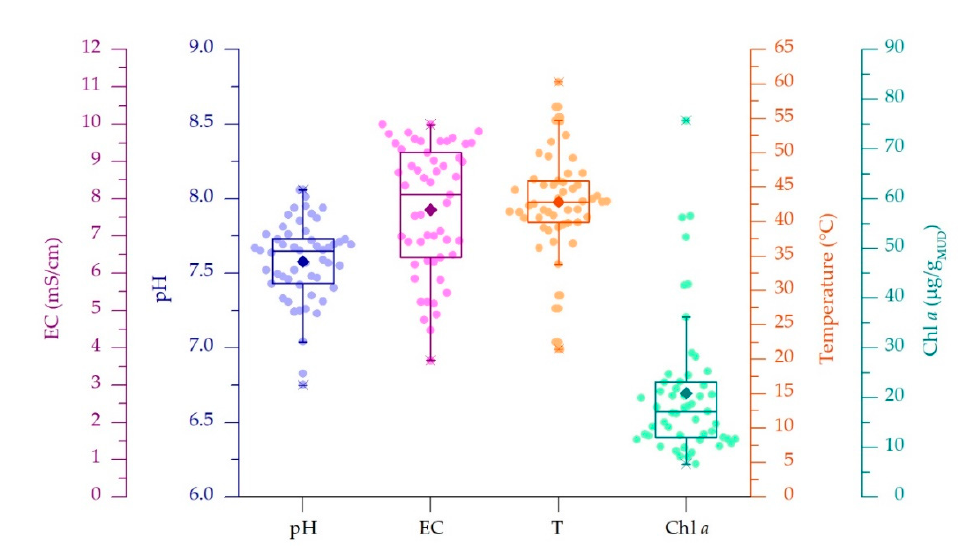
Figure 2. Distributions of data of thermal water physico-chemical parameters and of chlorophyll a content of mud samples. Boxplots showing average value (filled rhombus), median (horizontal lines), interquartile range (IQR) and 1.5 × IQR (with outliers indicated by X).